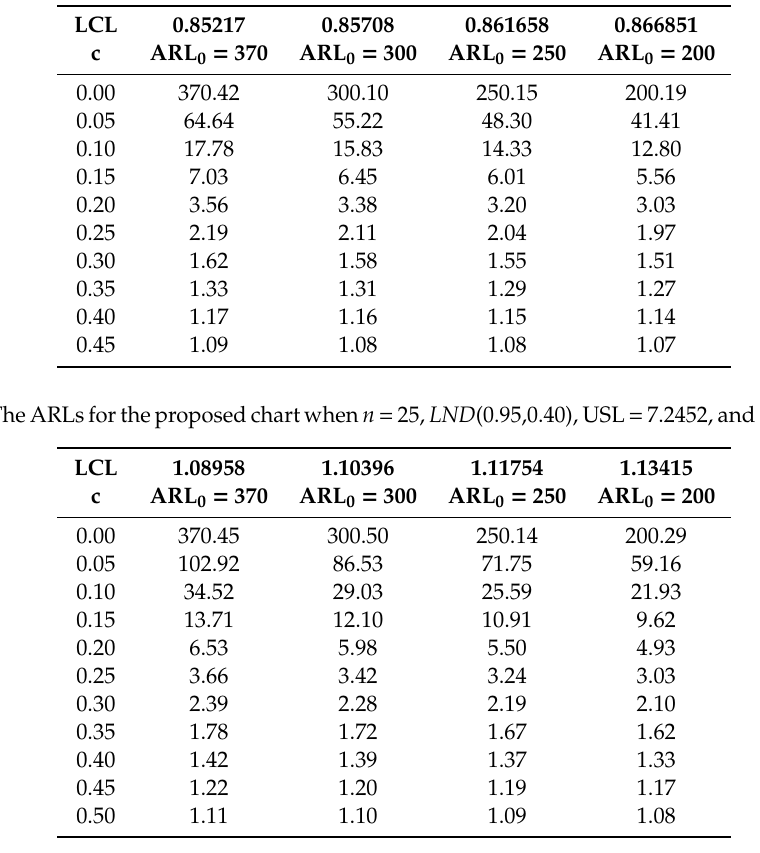
Table 16. The ARLs for the proposed chart when n = 50, LND (0.50,1.00), USL = 21.6678, and LSL = 0.1255.